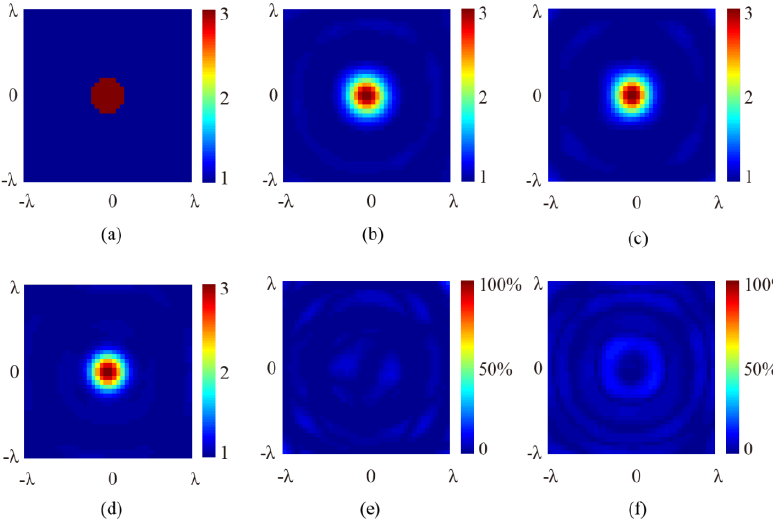
Figure 5. The retrieved cross-section profile of the centered 2D cylinder. ( a ) Original profile; ( b ) retrieved result at normal incidence; ( c ) retrieved result at 15° angle of incidence; ( d ) retrieved result at 30° angle of incidence; ( e ) relative error between 5c and 5b; and ( f ) relative error between 5d and 5b.